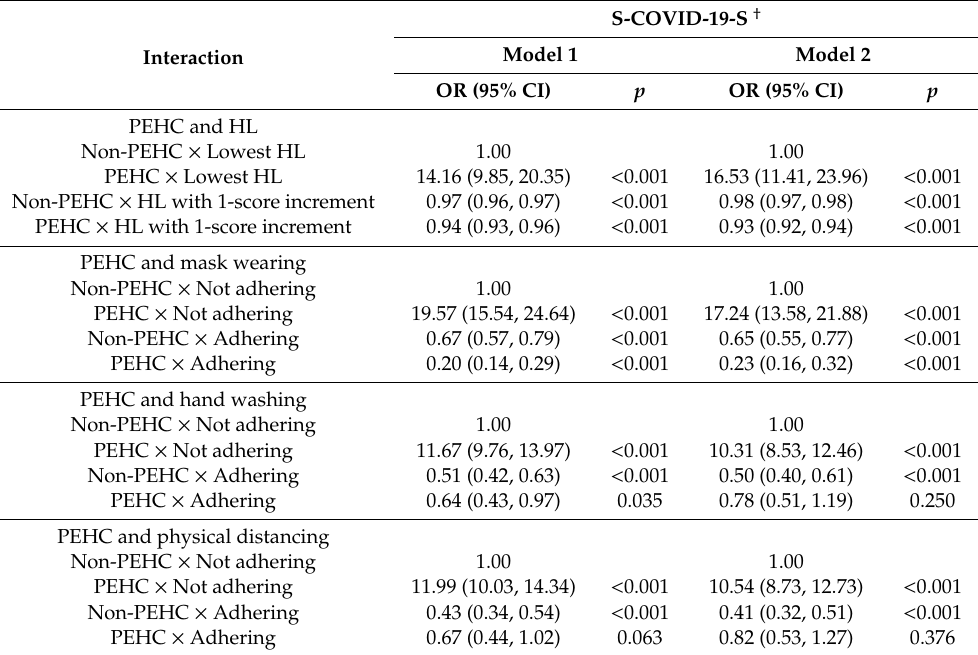
Table 3. Interactions of health literacy and preventive behaviors with pre-existing health conditions on suspected COVID-19 symptoms ( N =